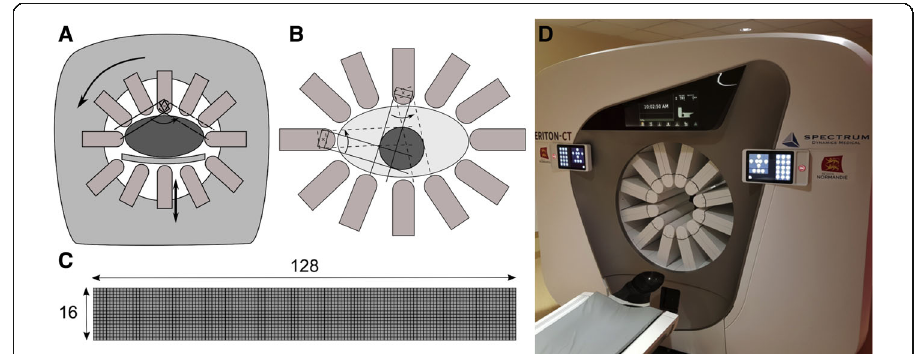
Fig. 1 General camera architecture showing the different movements of the 12 detectors ( a ), schematic principle of the focus mode showing the reduced swipe motion of detectors to a predefined region of interest shown in dark grey ( b ), design of the detection column consisting of an array of 16 by 128 pixel units ( c ) and picture of the system ( d